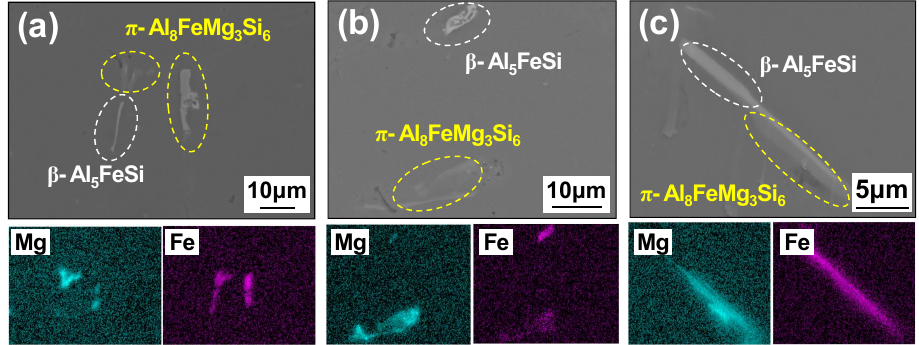
Figure 8. Mapping images of intermetallics in T5 heat-treated CPC A356 specimens at different T5 heat treatment conditions: ( a ) as-cast ( b ) 200 ◦ C-6 h ( c ) 200 ◦ C-9